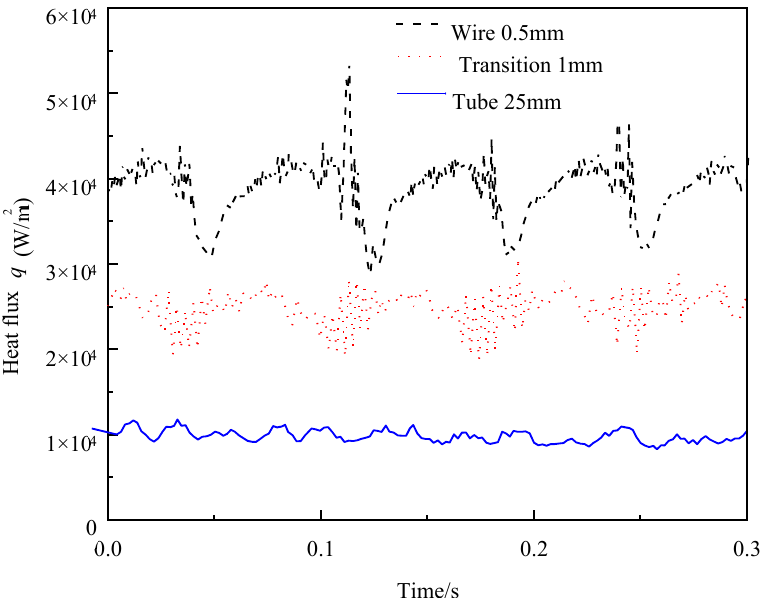
Figure 14. The spatial-averaged heat flux of horizontal cylinders with different diameters.